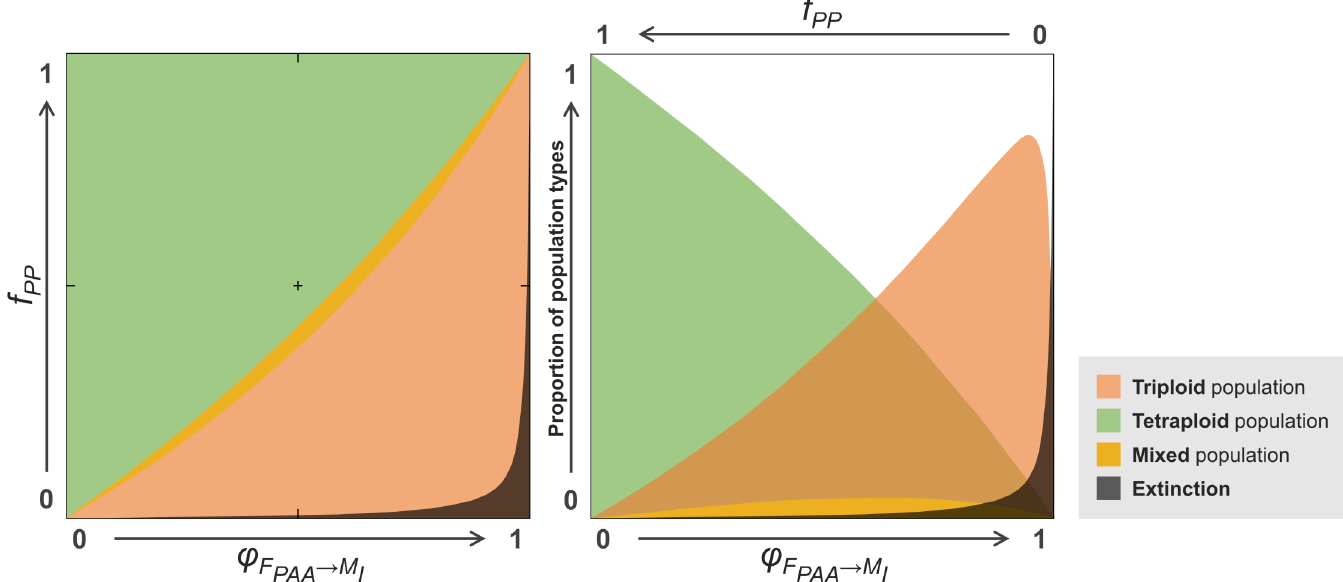
Fig 5. Range of scenarios leading to all population types predicted by the model. Tetraploid-dominated populations exclusively constituted by the PPAA genomotype are represented in green, whereas triploid-dominated populations composed by the PAA and the PA genomotypes are shown in red. Yellow represents the narrow area of scenarios leading to stable populations comprising the three genomotypes (PA, PAA and PPAA) in equilibrium. Lastly, the dark area represents populations exclusively constituted by the interdependent PAA genomotype and, therefore, the respective set of scenarios was considered to lead populations to extinction (see text for more